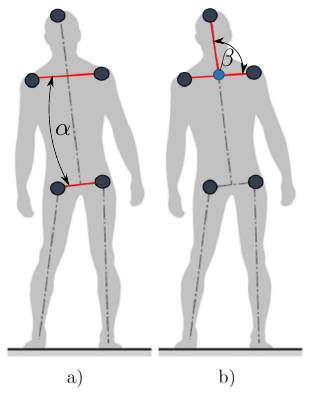
Figure 4. Definition of angles α and β .